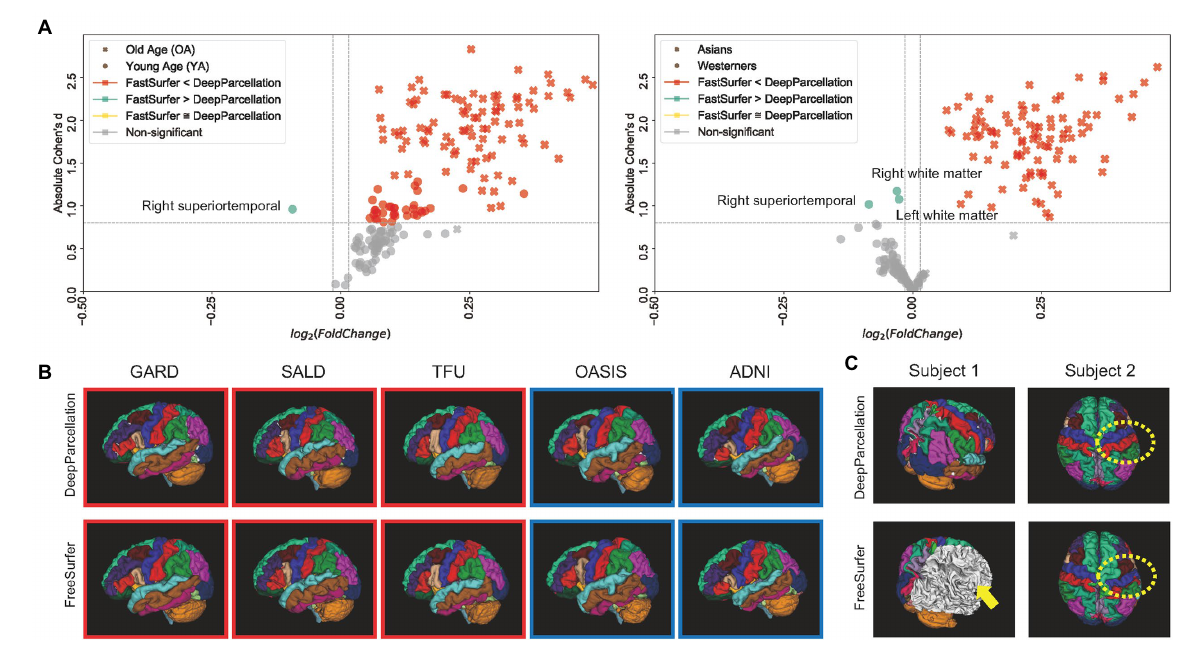
FIGURE 2 Performance of DeepParcellation. (A) Dice coefficient (DICE) comparison between DeepParcellation and FastSurfer. Using FreeSurfer output as surrogate for the ground truth, FastSurfer DICEs were baselines for calculating fold changes. Cohen’s d values were calculated using mean DICEs in two aspects (age and ethnicity). The horizontal line defines a Cohen’s d of 0.8, representing a large effect size. (B) Surface construction of parcellated brain images from representative subjects of different datasets. Red and blue squares indicate brains of Asians and Caucasians, respectively. (C) Examples of better parcellation with DeepParcellation compared with FreeSurfer. (A) Failures of right cortical parcellation in FreeSurfer (yellow arrows). (B) Wrong parcellation of right precentral and postcentral gyri in FreeSurfer (yellow dashed